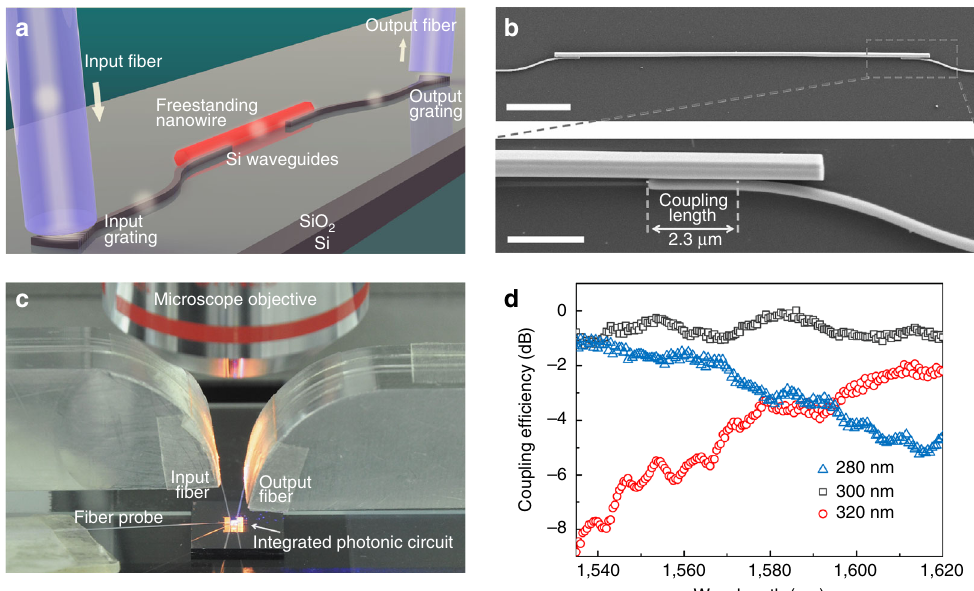
Fig. 1 Integration of a FNW into a silicon chip using side-by-side near- fi eld optical coupling. a Schematic illustration of the coupling scheme. The white arrows indicate the direction of light propagation. b Upper panel: scanning electron microscopy (SEM) images of a 730-nm-diameter CdS FNW coupled to 280-nm-width SWs at both ends. Scale bar, 10 μ m. Lower panel: close-up image showing the pre-de fi ned coupling length of about 2.3 μ m. Scale bar, 2 μ m. c Photograph of the measurement setup under an optical microscope. The silicon chip was illuminated by the microscope. d Measured coupling ef fi ciency between a 860-nm-diameter CdS FNW and SWs with widths of 280, 300, and 320 nm, respectively. The coupling lengths are about 2.5 μ